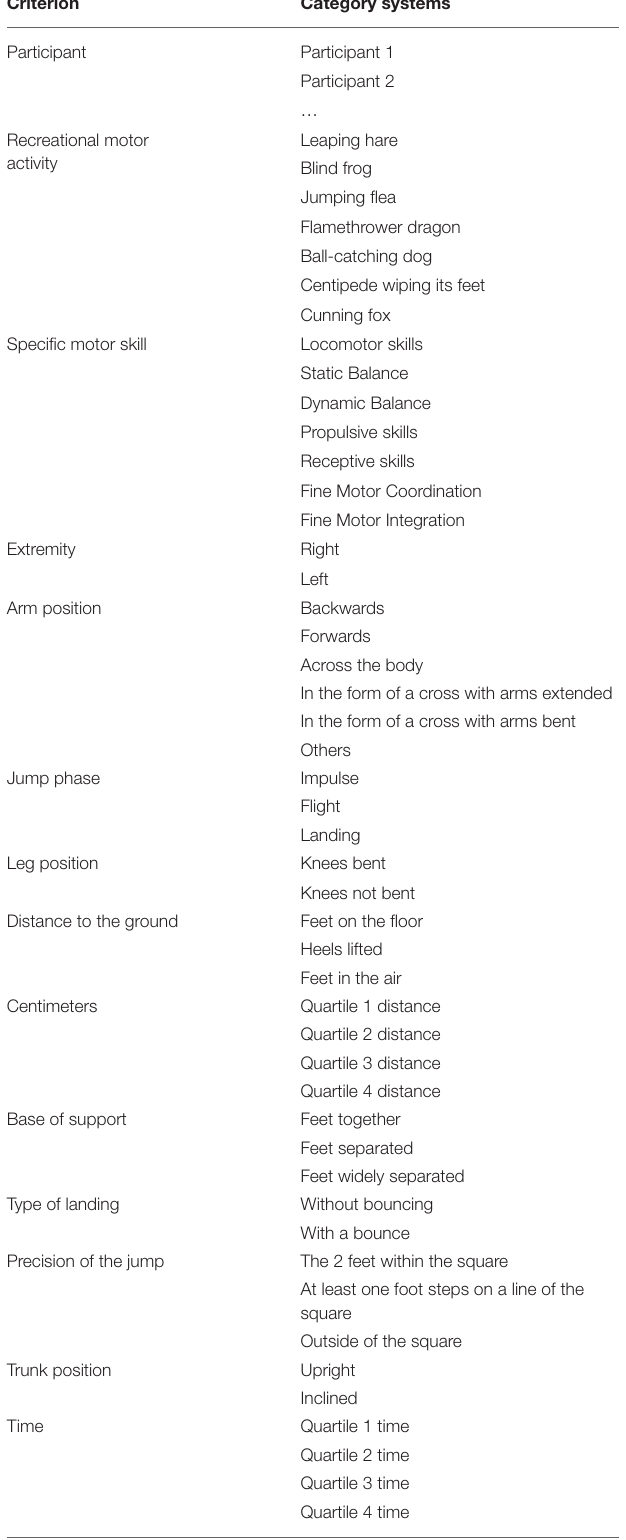
TABLE 1 | Observation instrument: criteria and